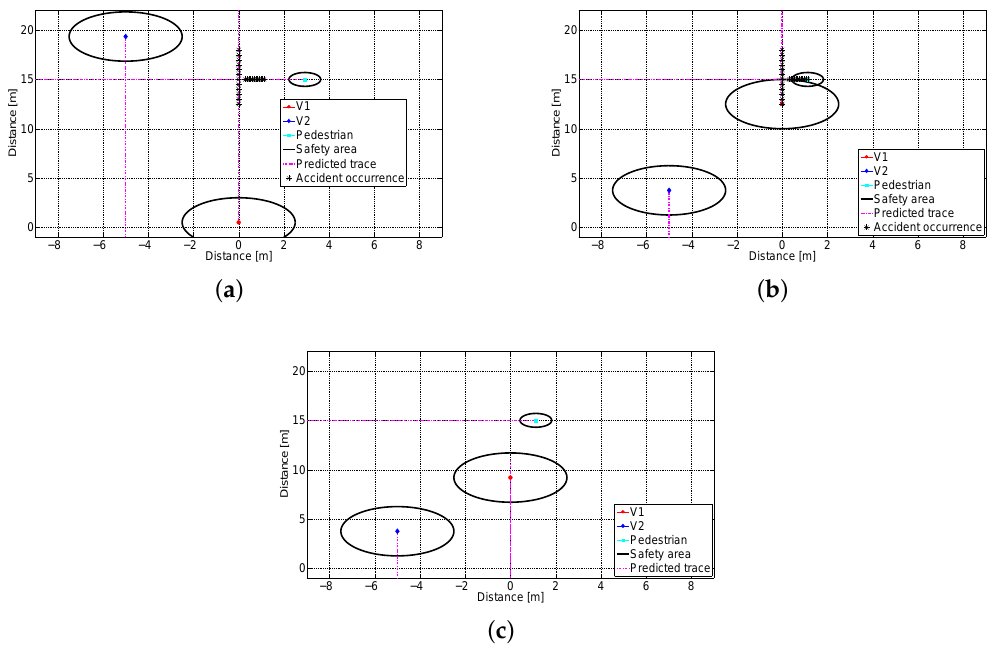
Figure 13. Snapshots of the scenario modeling: ( a ) Traces at t = 0 s. ( b ) Traces at t = 1.2 s without the proposed system. ( c ) Traces at t = 1.2 s with the proposed